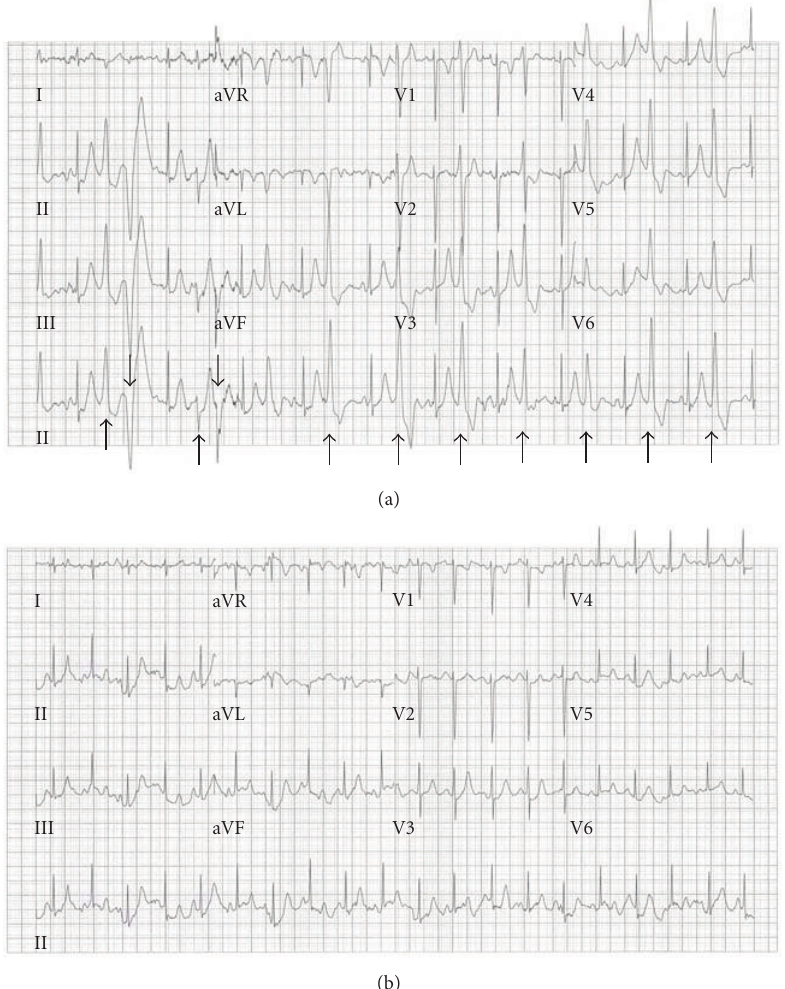
F 3: Exercise Treadmill Test. (a) Peak-exercise ECG on initial ETT, prior to antiarrhythmic medications, showing polymorphic PVCs and bigeminy (arrows). (b) Peak-exercise ECG on ETT during esmolol infusion, showing sinus rhythm with suppression of